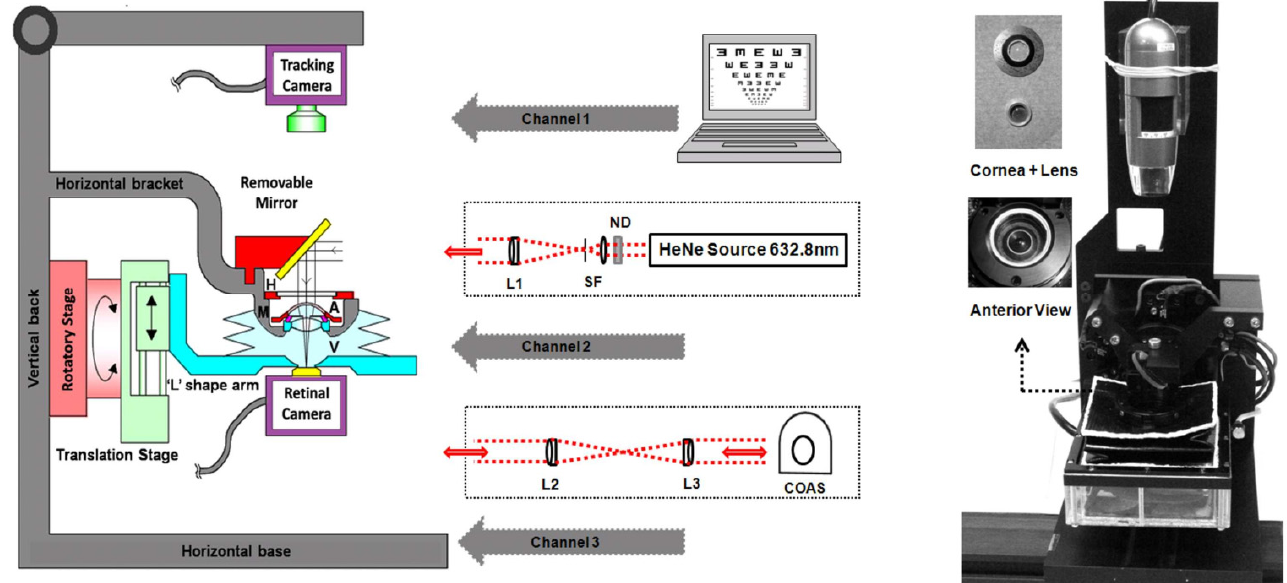
Figure 13. ( Left ) Schematic painting of the artificial eye used by Barakraju et al.; ( Right ) photograph of the device. A magnified overview of the anterior chamber of the model eye shows the humidity chamber, cornea, and sclera. The individual cornea and crystalline lens are also shown. Optics Express 2010, 18, 16868–16882 ([37]). Originally published by and reprinted with permission from Optica Publishing Group.